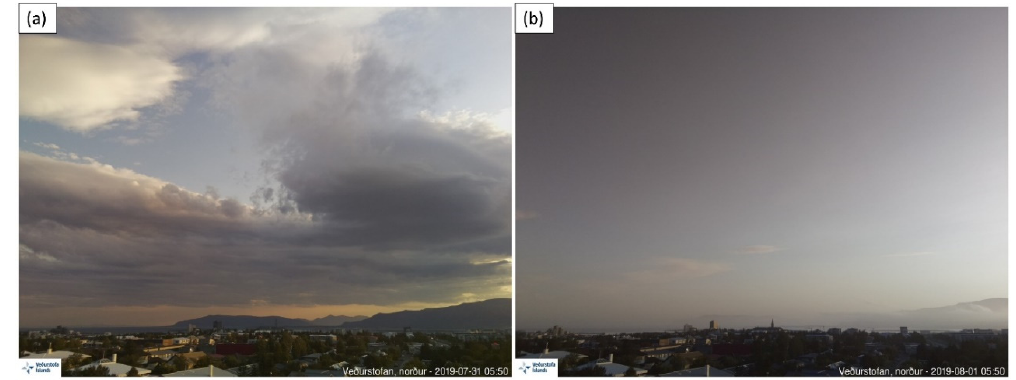
Figure 9. Photos taken by a web camera at IMO on 31 July ( a ) and 1 August ( b ), 2019, both dates at 05:00 UTC. The camera is looking northward and the view is the same as in Figure 5.